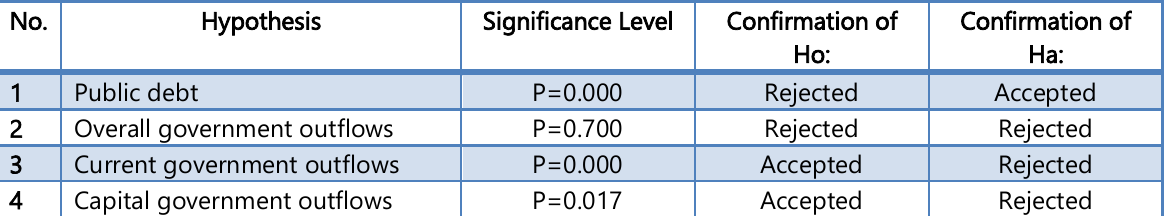
Table 4: Estimation Results (Source: Author’s calculation)